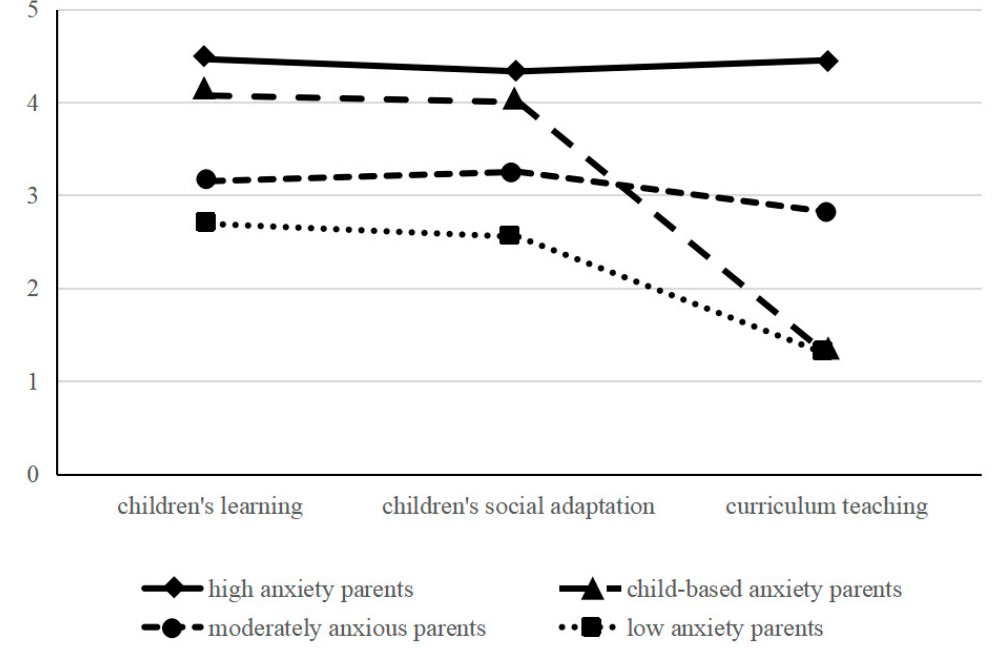
Figure 1. Latent classes of parental educational anxiety. Table 2. Descriptive statistics for parental educational anxiety in relation to different background